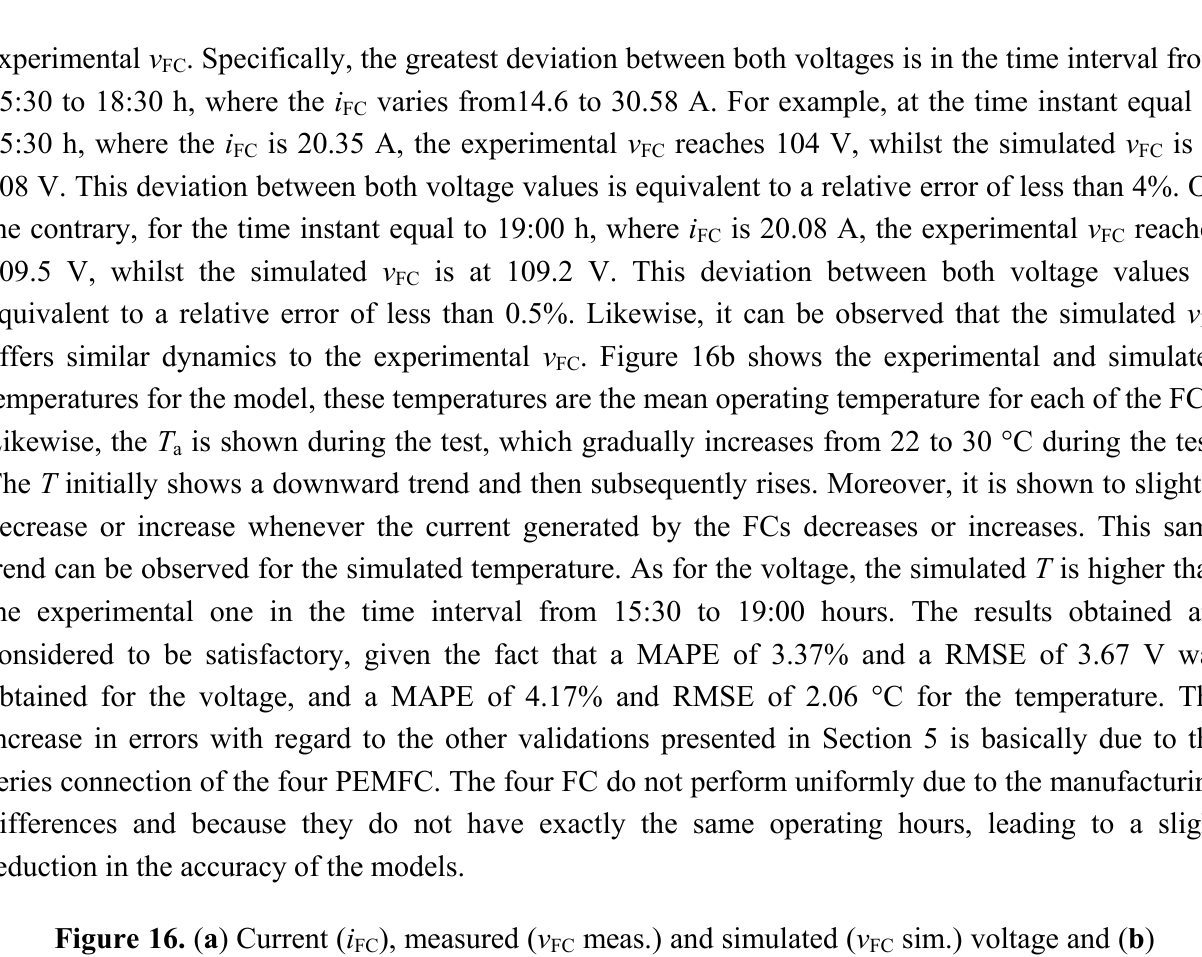
), measured ( v meas.) and simulated ( v sim.) voltage and ( b ) Figure 16. ( a ) Current ( i FC FC FC measured ( T meas.) and simulated ( T sim.) FC operating temperature and ambient ) for the power profile drawn from the microgrid storage system comprising temperature ( T a 4 PEMFCs, plotted in Figure